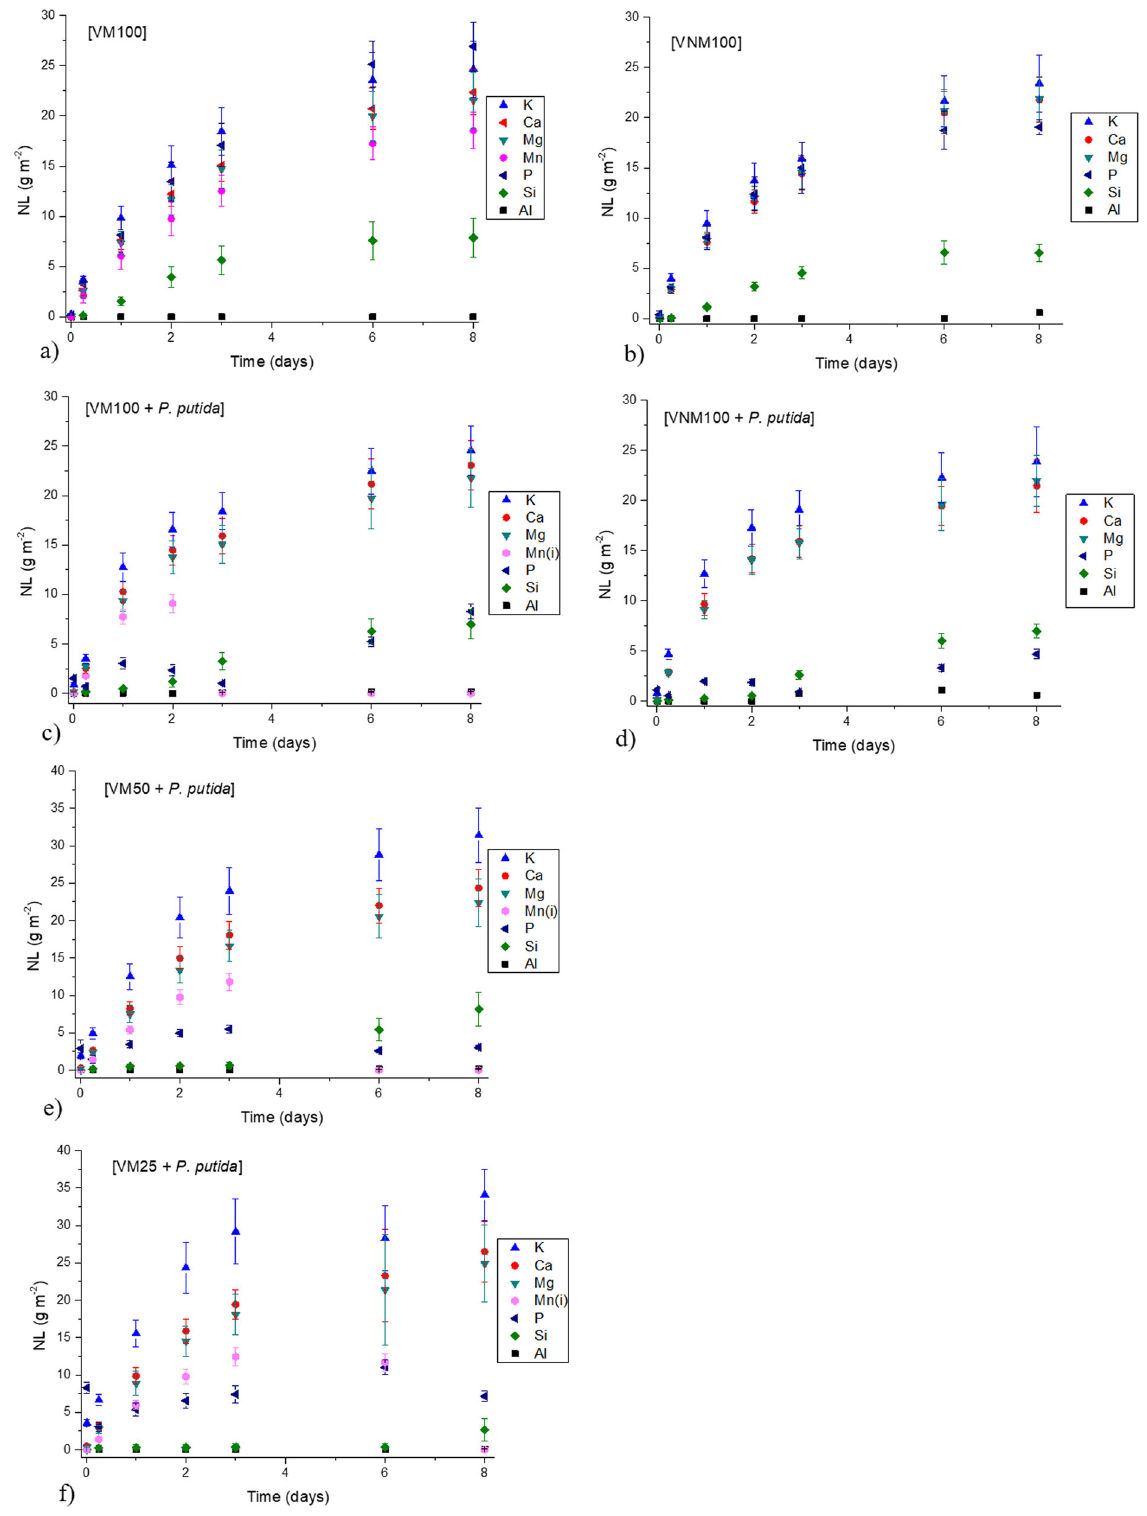
Fig. 5 Average normalized mass losses versus time. Experiments a [VM100], b [VNM100], c [VM100 + P. putida ], d [VNM100 + P. putida ], e [VM50 + P. putida ], f [VM25 + P. putida ]. Uncertainty bars correspond to the uncertainties calculated taking into account the analytical ICP- OES error (10%), and the standard deviation for the